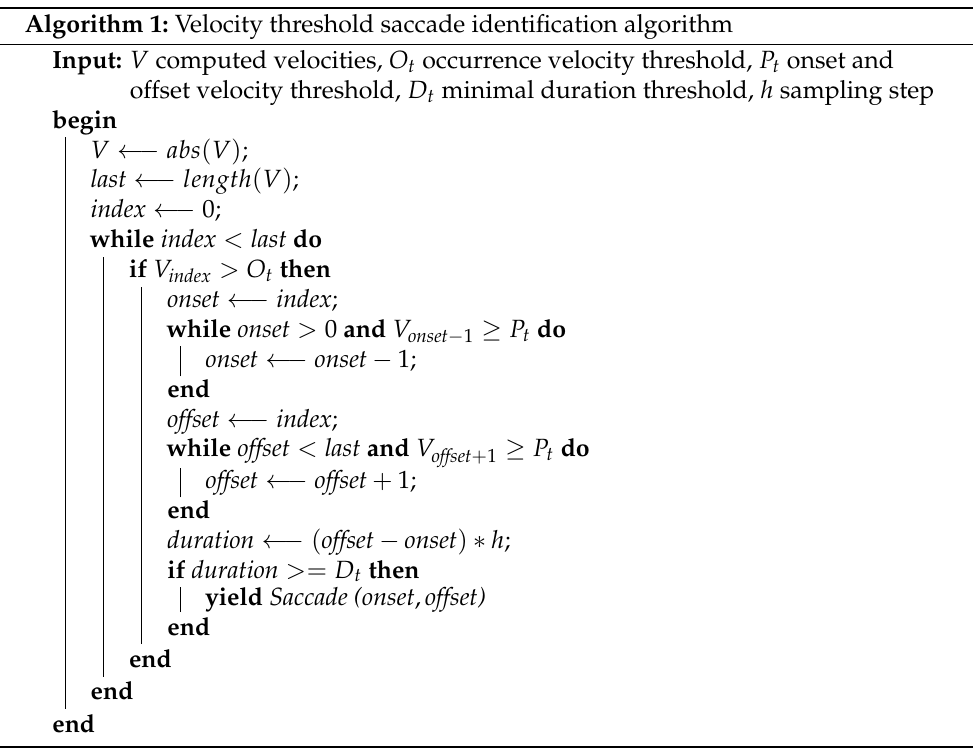
Algorithm 1: Velocity threshold saccade identification